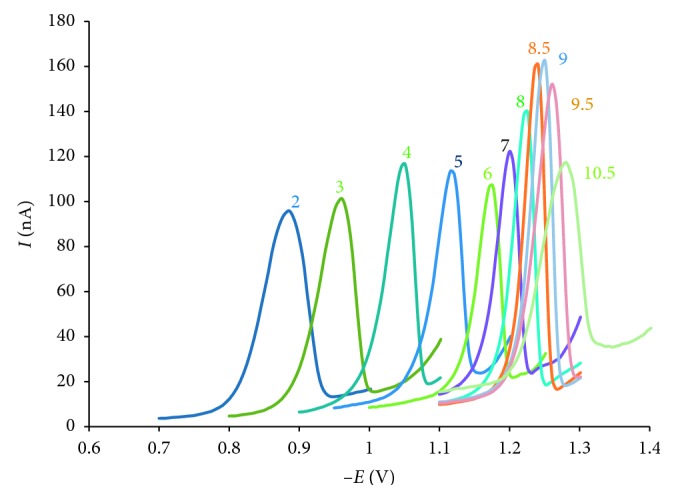
Adsorptive stripping voltammograms for 10−7 mol·L−1 AO in BR buffer of different pH 2.0–10.5; Eacc = −0.5 V, tacc = 30 s, and scan rate 250 mV·s−1.